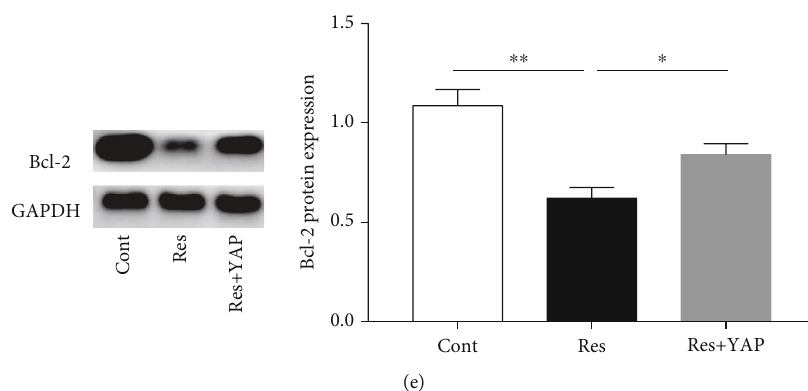
Figure 8: YAP overexpression inhibits the e ff ects of Res on the inactivation of HSCs. (a) YAP mRNA expression. (b) α -SMA protein expression. (c) Type I collagen expression. (d) Bax protein expression. (e) Bcl-2 protein expression. Values are expressed as means ± SD . ∗ P < 0 : 05 , ∗∗ P < 0 : 01 , and ∗∗∗ P < 0 : 001 .